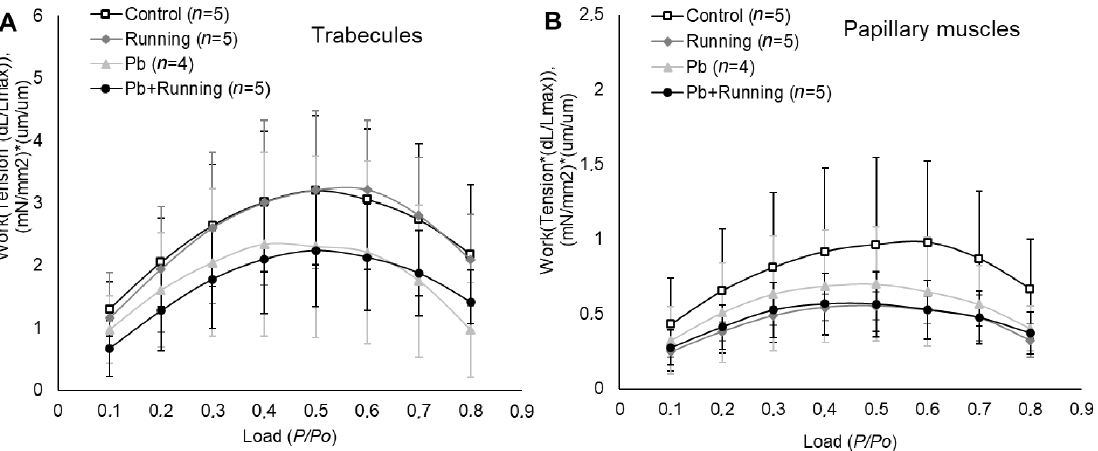
Figure 9. The work–afterload relationships of trabecules ( A ) and papillary muscles ( B ) in the experimental groups. The number of preparations is given in brackets. Data are presented as mean ± S.D.